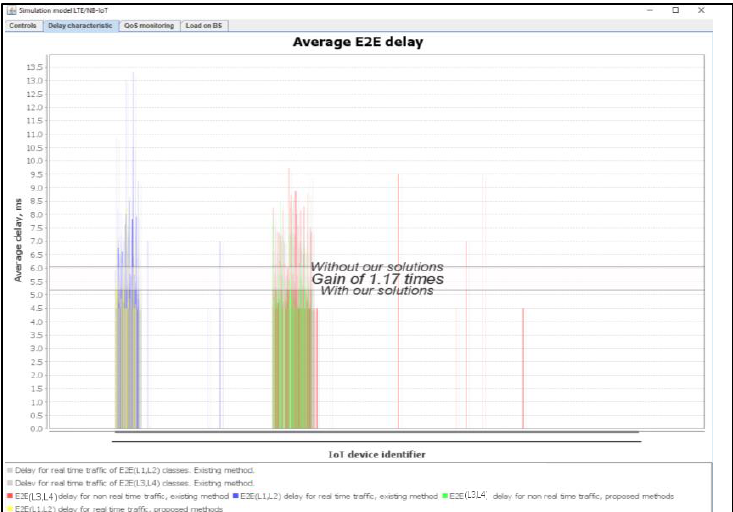
Figure 13. Estimated average E2E delay gain of IoT services with our solution (average load of IoT controller ρ = 12%).